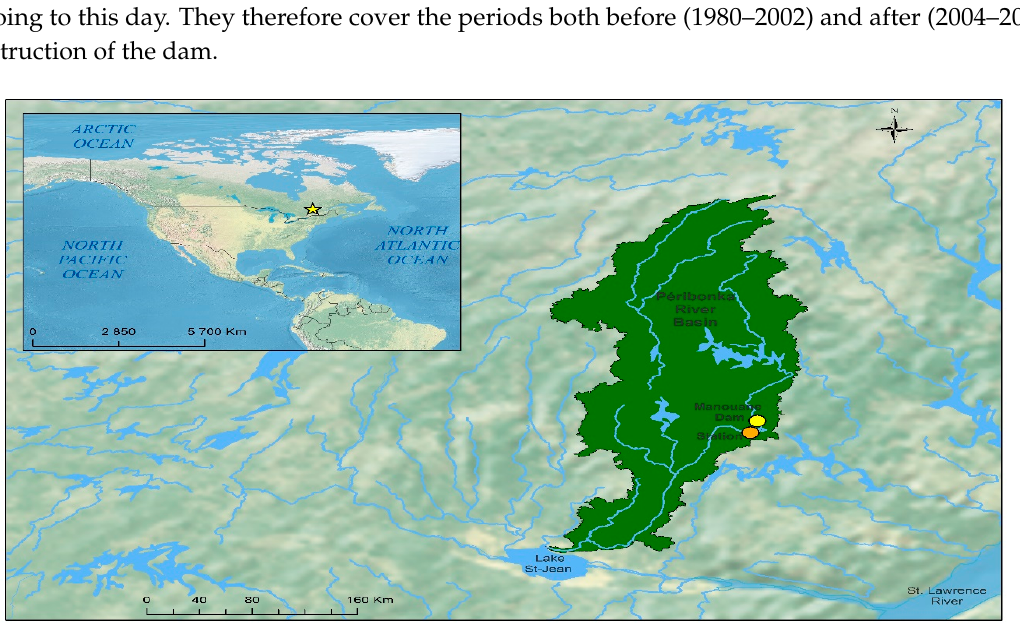
Figure 1. Location of the Manouane River watershed and diversion dam. The orange dot shows the location of the flow gauging station.